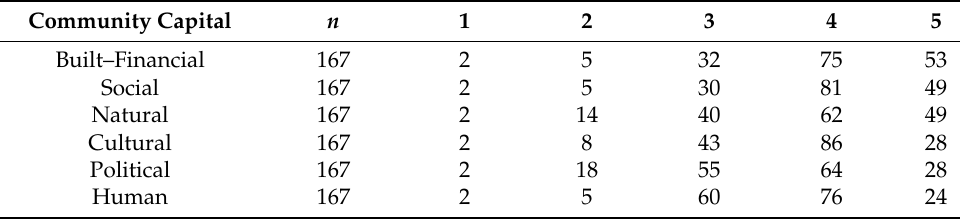
Table 1. Absolute Rating Frequency Counts for Single